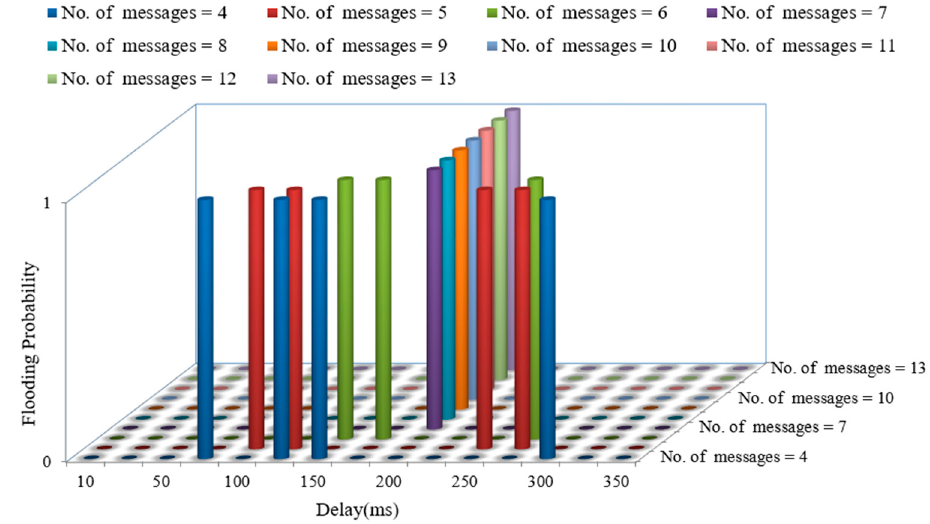
Figure 7. The Flooding Probability curve with respect to number of messages and delays.